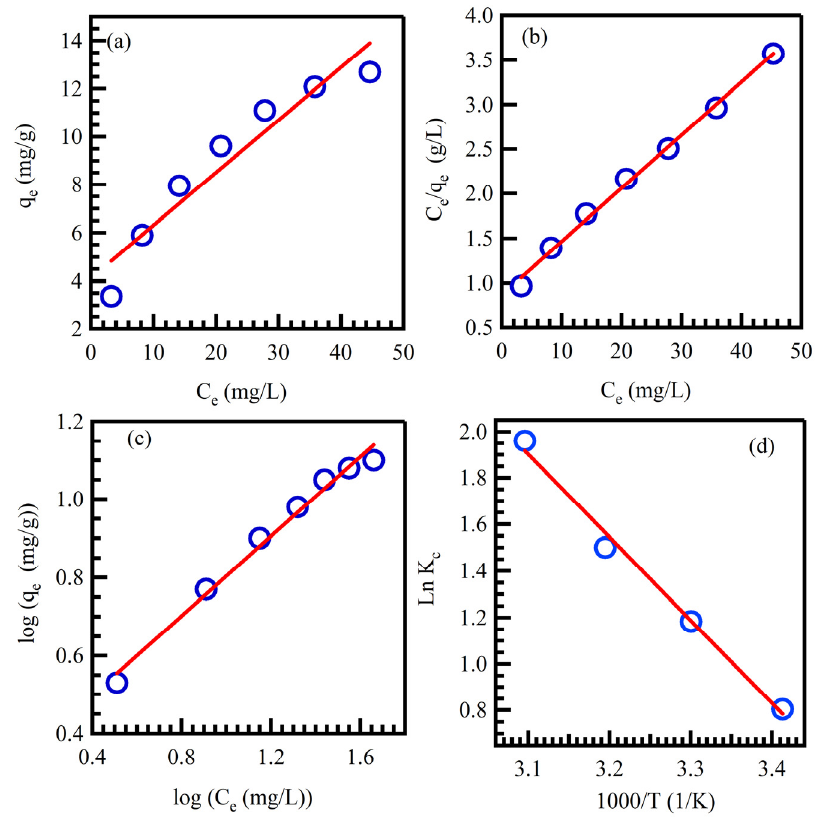
Figure 6. The plot q e vs. C e ( a ), Langmuir ( b ), Freundlich ( c ), and ln K c vs. 1000/T of Ceph onto HAP( d